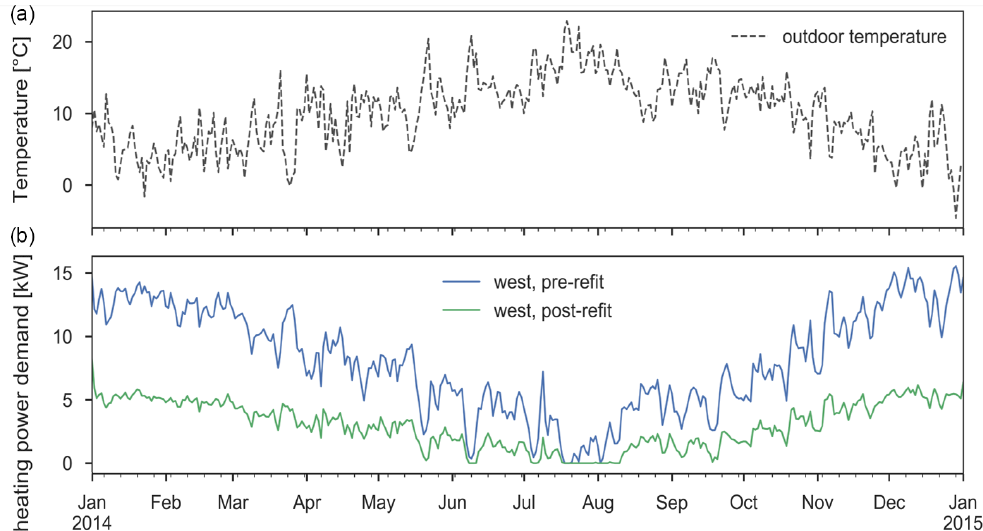
Figure 2. (a) Outdoor temperature curve of a weather station in the vicinity of the study area. (b) Heat demand curves for one house in the western model in pre-renovated (blue line) and post-renovated (green line)